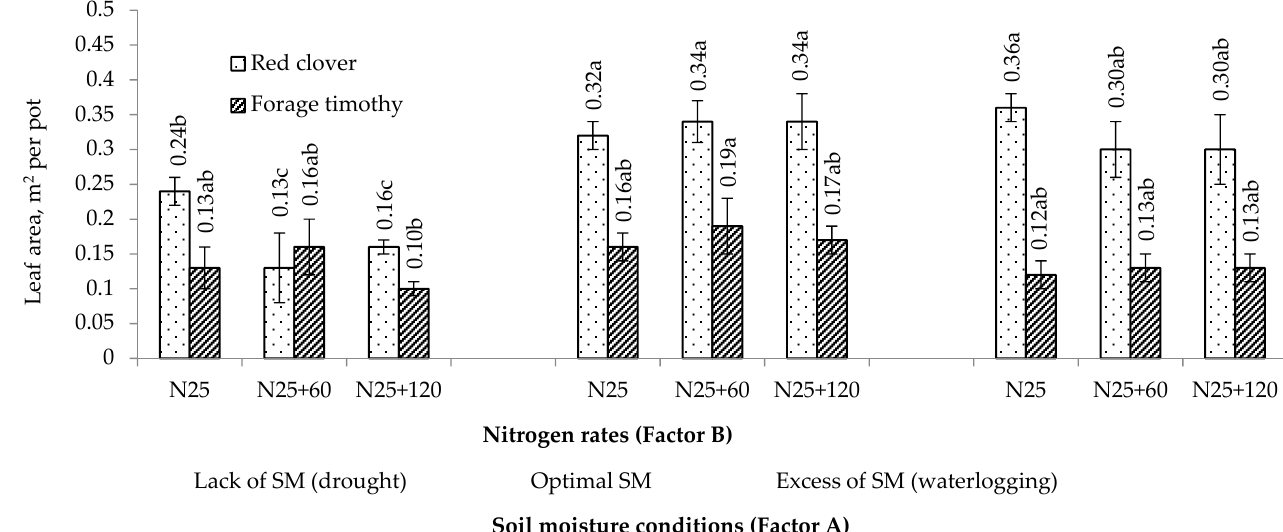
Figure 6. Assimilating leaf area of red clover and forage timothy. Note, differences between the means of treatments for separate plant species, marked by different letters (a, b, c), are significant ( p < 0.05). Whiskers indicate standard errors of the means. SM—soil moisture.